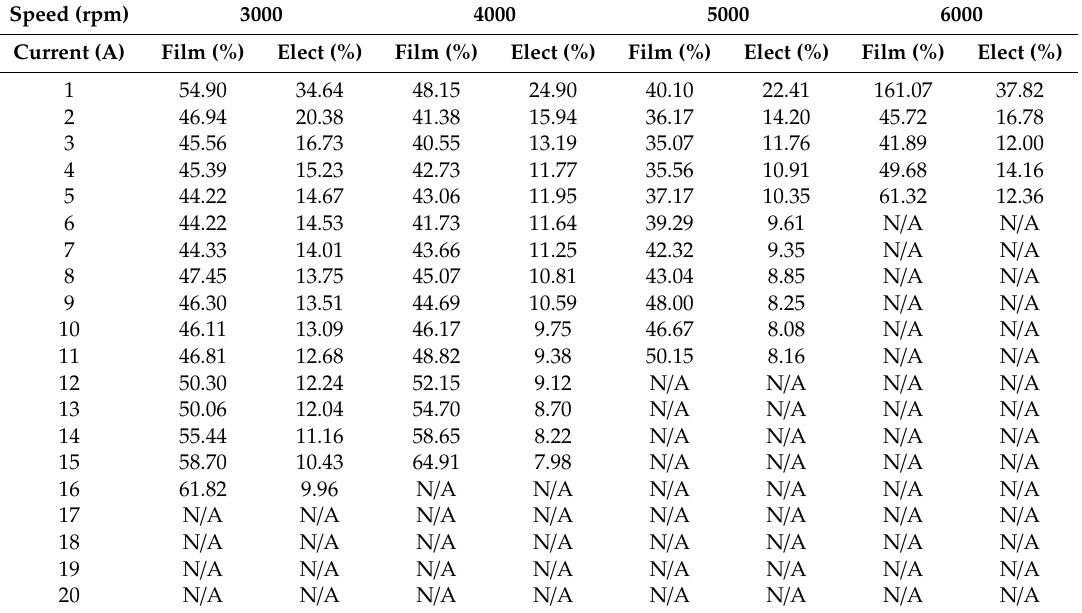
Table 3. Percent RMS DC-link current obtained by the VSI with electrolytic and film capacitor at an rpm range of 3000–6000.